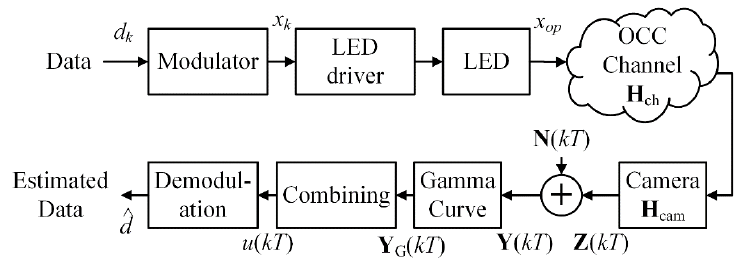
Figure 36. Top level schematic of a typical OCC system. Three different colors (red, green, and blue) used as optical source modulations, us- ing the color shift keying (CSK) technique at the data rate of 150 bps and 5.2 Kbps, are